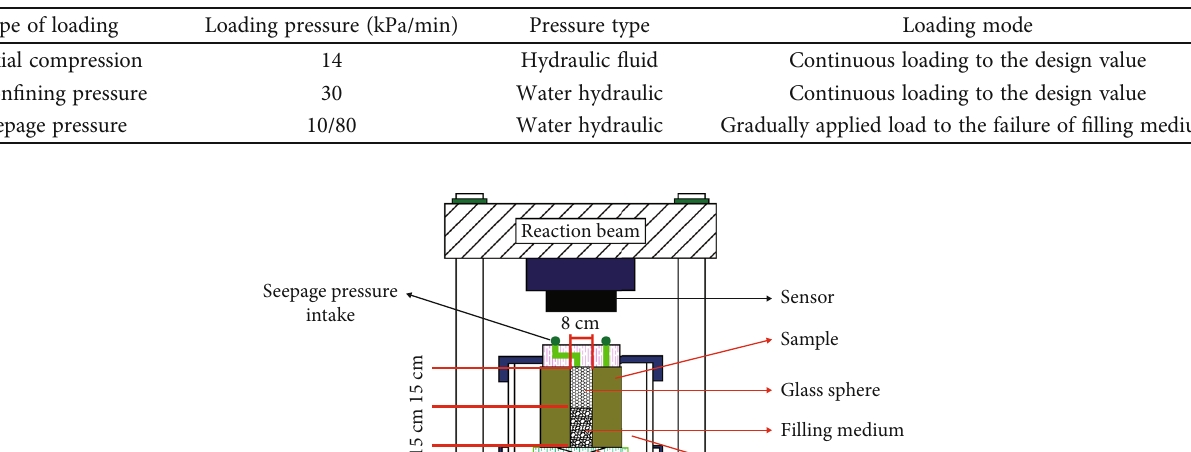
Table 4: Loading schemes of permeability tests.